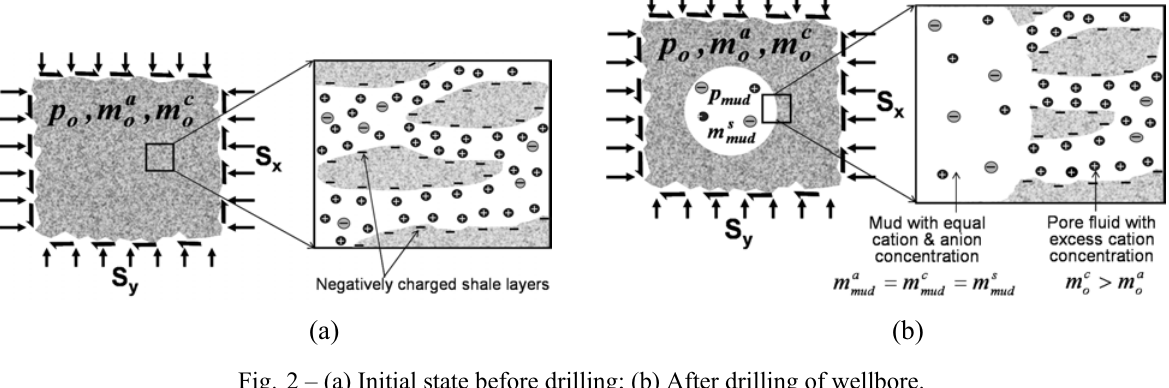
Fig. 2 – (a) Initial state before drilling; (b) After drilling of